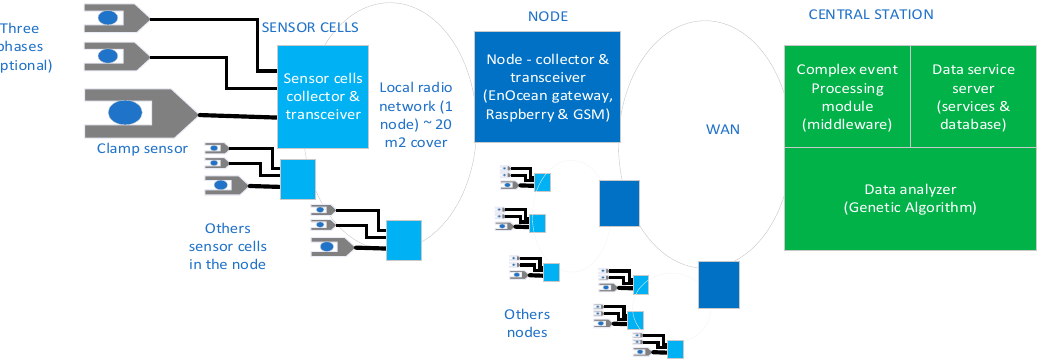
Figure 2. Block diagram of the monitoring platform.